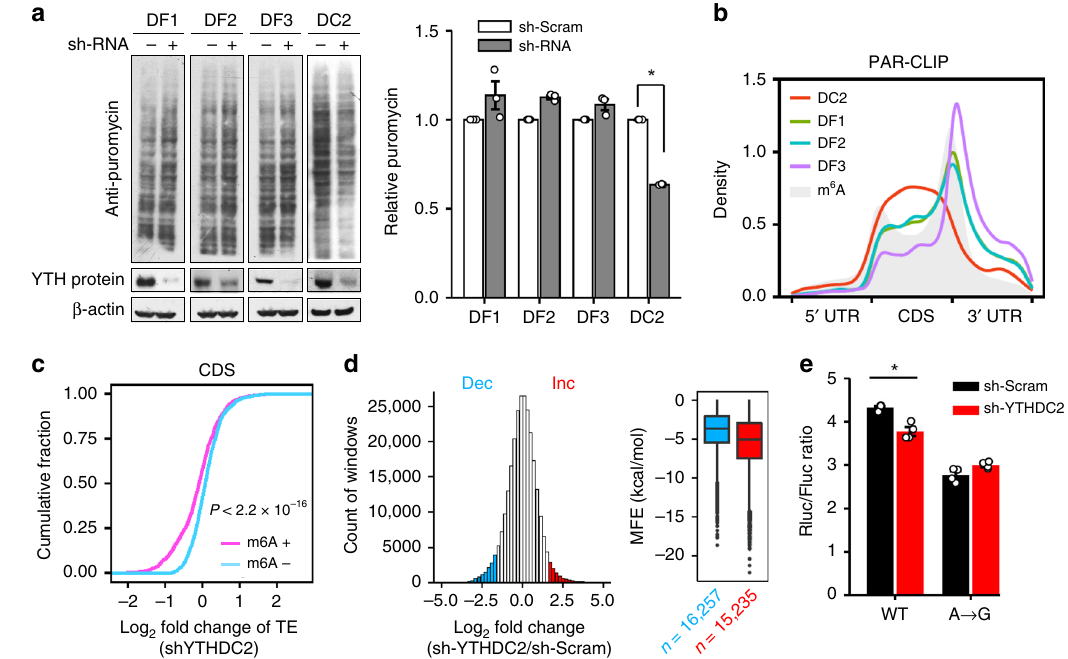
Fig. 4 YTHDC2 promotes translation ef fi ciency by acting on CDS m 6 A. a Puromycin labeling assay shows the global protein synthesis in HEK293 cells lacking each individual cytoplasmic m 6 A reader proteins. The right panel shows the quantitative results based on puromycin signals normalized with β -actin. Error bars, mean ± s.e.m.; t est, n = 3, * P < 0.05. DF1: YTHDF1, DF2: YTHDF2, DF3: YTHDF3, DC2: YTHDC2. b Distribution of the binding sites of cytoplasmic m 6 A reader proteins across the human transcriptome. All binding sites are identi fi ed from PAR-CLIP data sets obtained from HeLa cells. The distribution of m 6 A sites is shown as gray. c The fold change of translation ef fi ciency upon YTHDC2 knockdown is plotted as accumulative fractions (Wilcox test, P < 2.2 × 10 − 16 ) for transcripts bearing CDS methylation (m 6 A + ) or not (m 6 A − ). Both groups have similar levels of basal TE. d A histogram shows the distribution of changes of regional ribosome density in response to YTHDC2 knockdown. A sliding window of 30 nt in length with a step of 3 nt are used to calculate the local ribosome density. Regions with <1/3-fold (Dec, blue) and >3-fold (Inc., red) changes are highlighted by color coding. The right box plot shows the predicted minimum folding free energy (MFE) for regions with <1/3-fold (Dec) and >3-fold (Inc.) changes (Wilcox test, P < 2.2 × 10 − 16 ). The median of MFE in each group is indicated by a center line, the box shows the upper and lower quantiles, whiskers shows the 1.5× interquartile range, and the outliers are indicated by points. e The ratio of Rluc/Fluc in transfected cells expressing wild type or mutant reporters, with or without YTHDC2 knockdown. Error bars, mean ± s.e.m.; Single-tailed t test, n = 4, * P < 0.05. Source data are provided as a Source Data fi